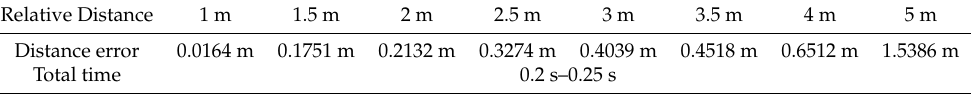
Table 3. Results of relative distance estimation.